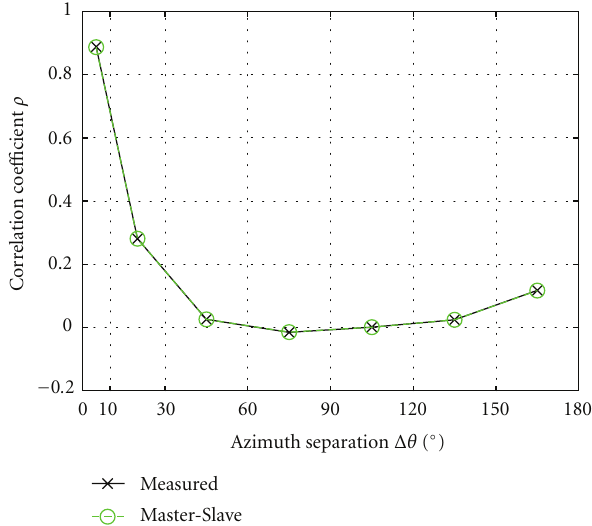
Figure 7: State correlation coe ffi cient ρ between two satellites with dependency on the azimuth angle separation Δ θ derived from measurements and recalculated with Master-Slave. The Master- Slave approach with Conditional Assembling Method presented in this paper resimulates accurately the correlation coe ffi cients for the two-satellite constellation (master and slave). The elevation angles are φ 1 = φ 2 = 15 ◦